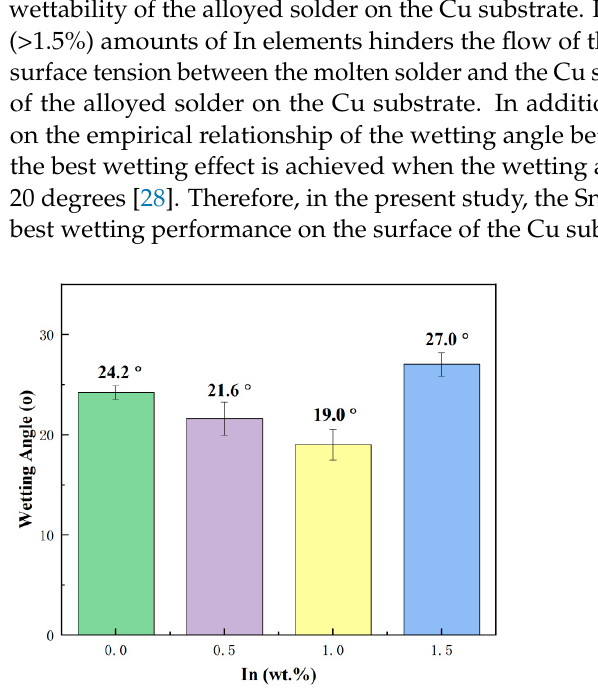
Figure 4. Wetting angle of SnBiAg–xIn (x = 0, 0.5, 1.0, 1.5) alloy solder on Cu substrate surface.